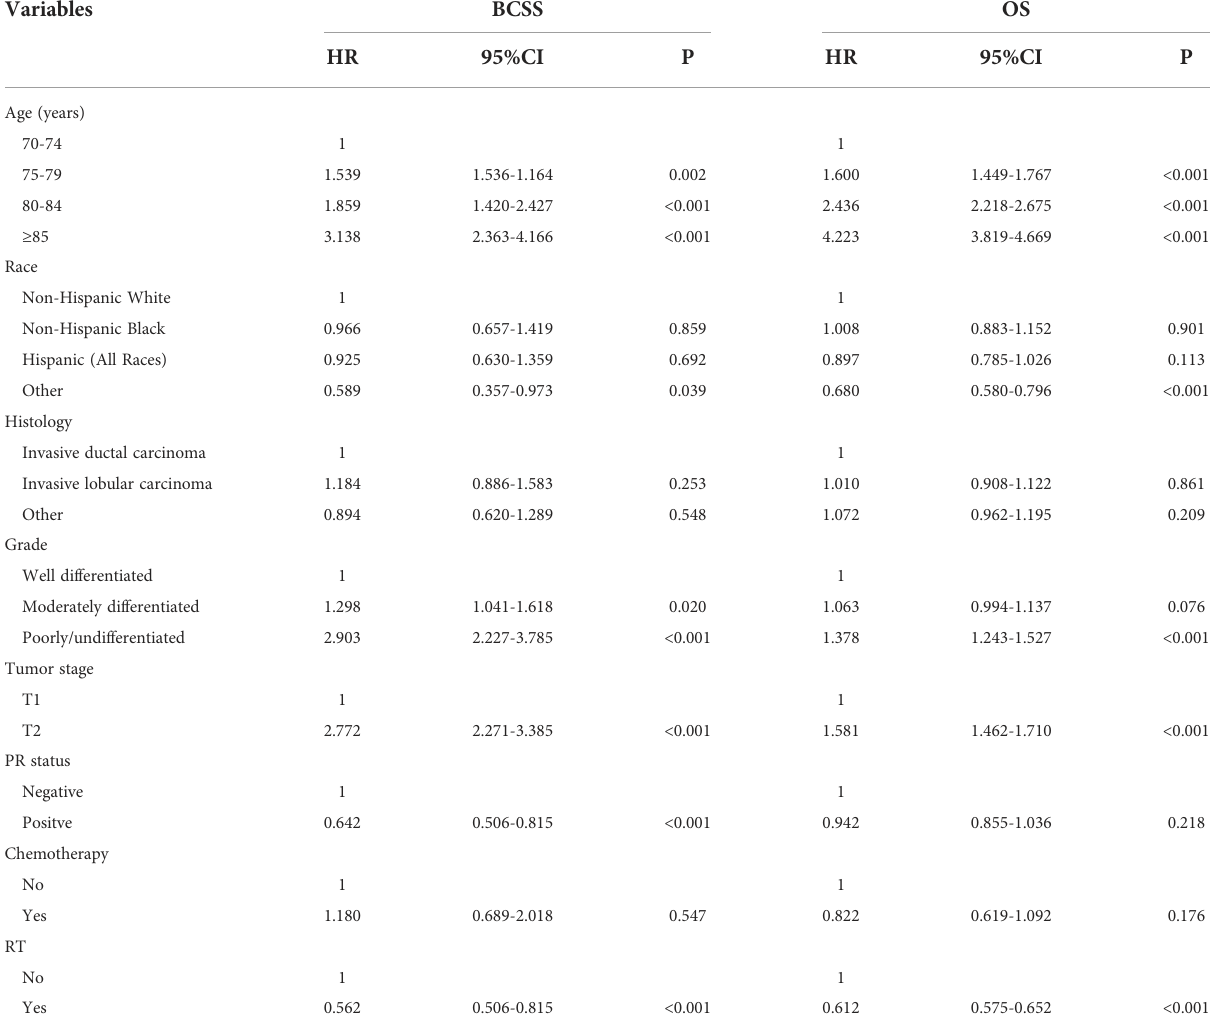
TABLE 3 Multivariate prognostic analysis after propensity score matching.